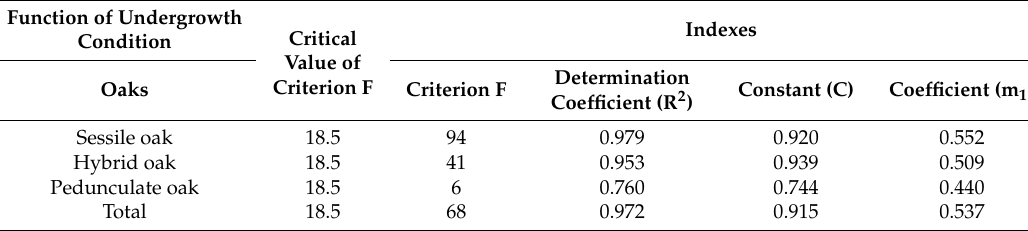
Table 6. Group regression analysis of the dependence of the formation period of the total amount ( N p,t ) of oak trees